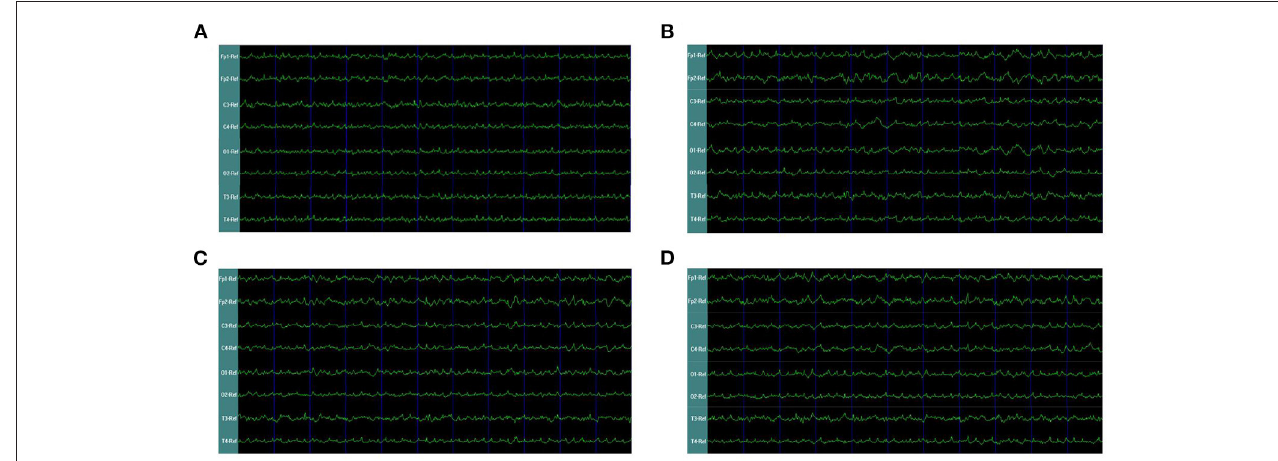
FIGURE 4 | EEG waveforms of left-side TBI in rats. (A) EEG waveforms of control subgroup (B) EEG waveforms recorded immediately after TBI (C) EEG waveforms of 7 days after TBI without treatments (D) EEG waveforms of TBI after 7-days treatment of 40hz Blue LED.